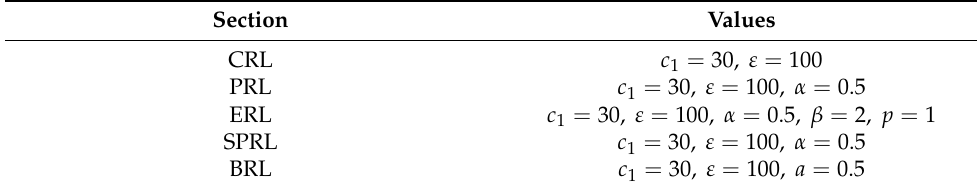
Table 1. Parameters of the presented control algorithm.